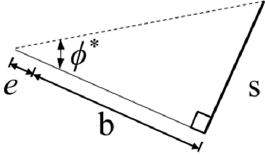
Figure A2. Triangle bounded by bold-dashed lines seen in Figure A1.